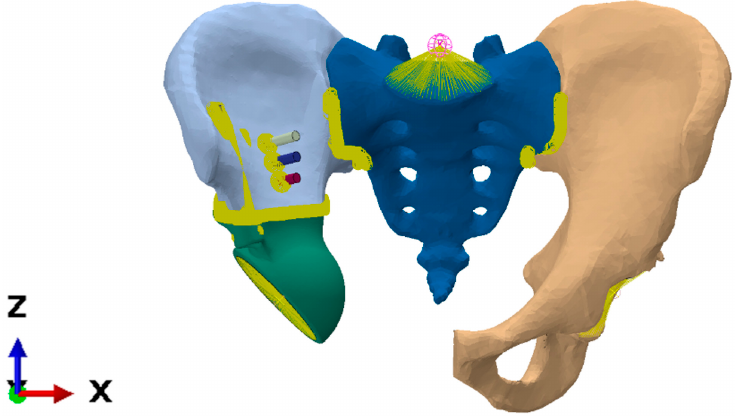
Figure 11. Visualization of interconnected nodes in the finite element model.